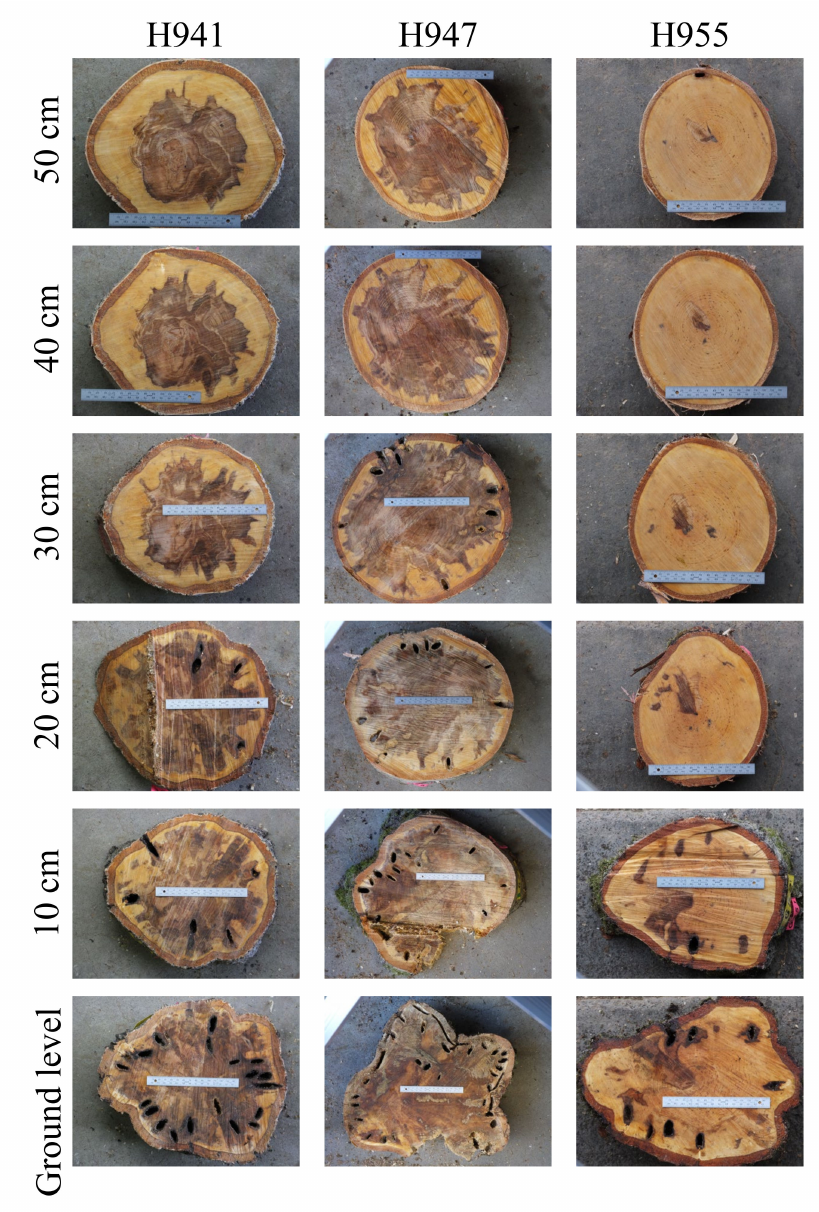
Figure 4. Examples of cross-sections of infested trees (#H941, #H947, and #H955) with different heights above the ground. Wood was decayed severely in #H941 and #H947, but was almost intact in #H955. Scale = 15